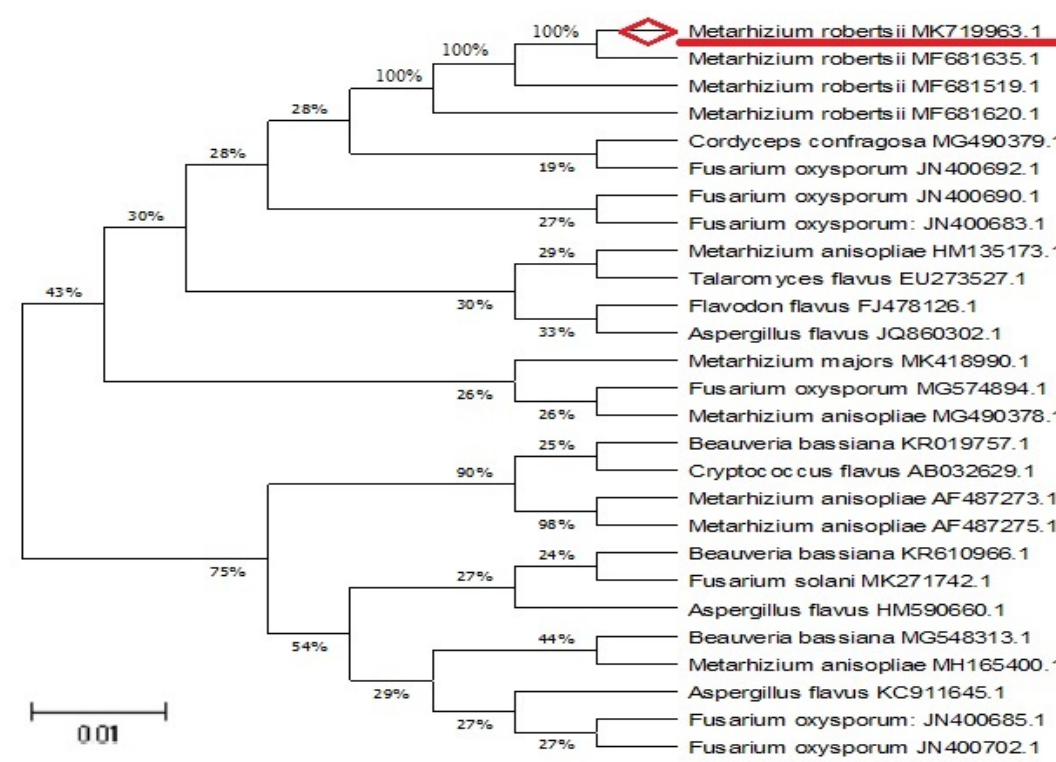
Figure 2. Neighbor-joining tree of the M. robertsii (MK719963.1) species closely related to the M. robertsii fungi.